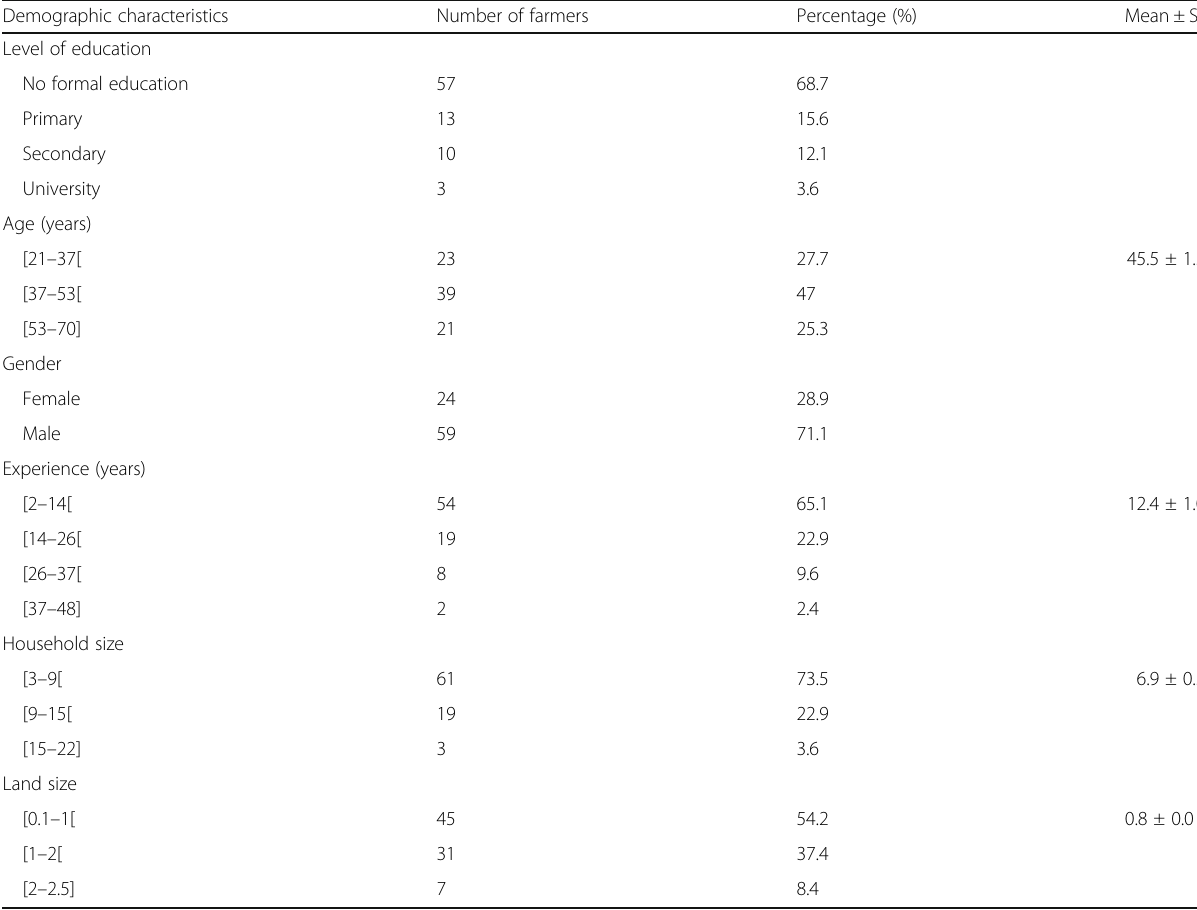
Table 1 Socio-demographic characteristics of surveyed households in the study area ( N *=83) Demographic